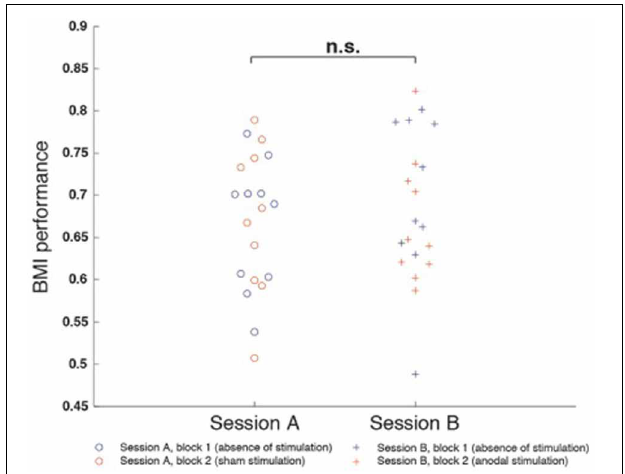
FIGURE 4 | Motor imagery (mu-event-related desynchronization, mu-ERD)-based brain-machine interface (BMI) performance was defined as the percentage of time mu-ERD was detected during trials. BMI performance was comparable between both sessions and did not exhibit differences between block 1 and block 2. There was neither a difference between block 1 of session A and session B ( p = 0 . 541), nor a difference between block 1 and block 2 of session A ( p = 0 . 880) or session B ( p = 0 .